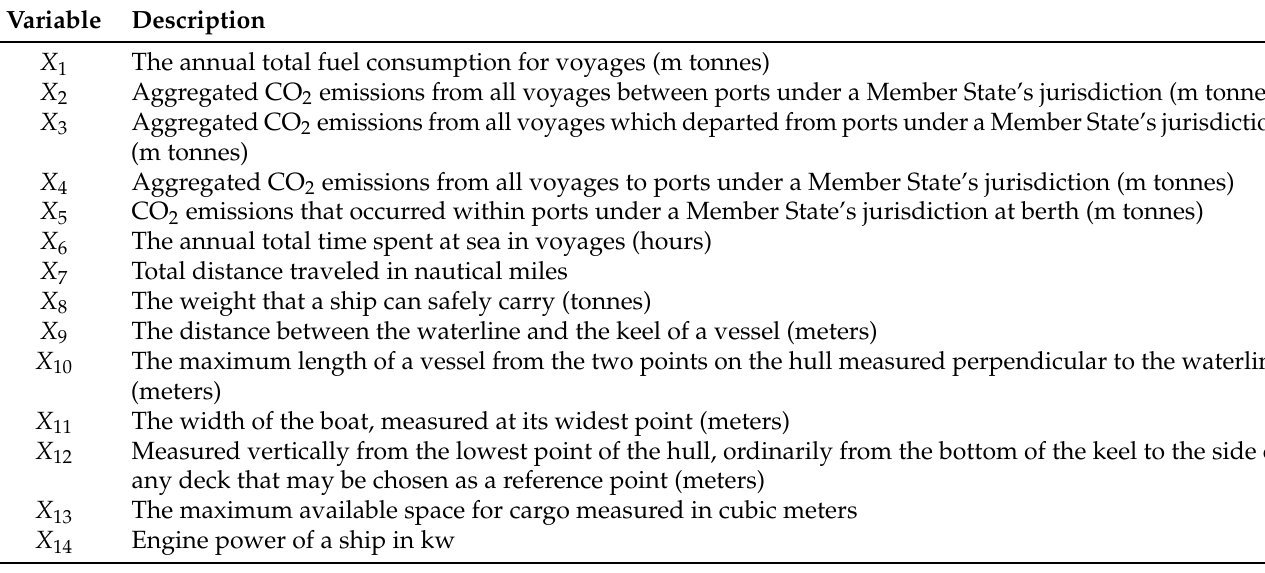
Table 1. Data Set